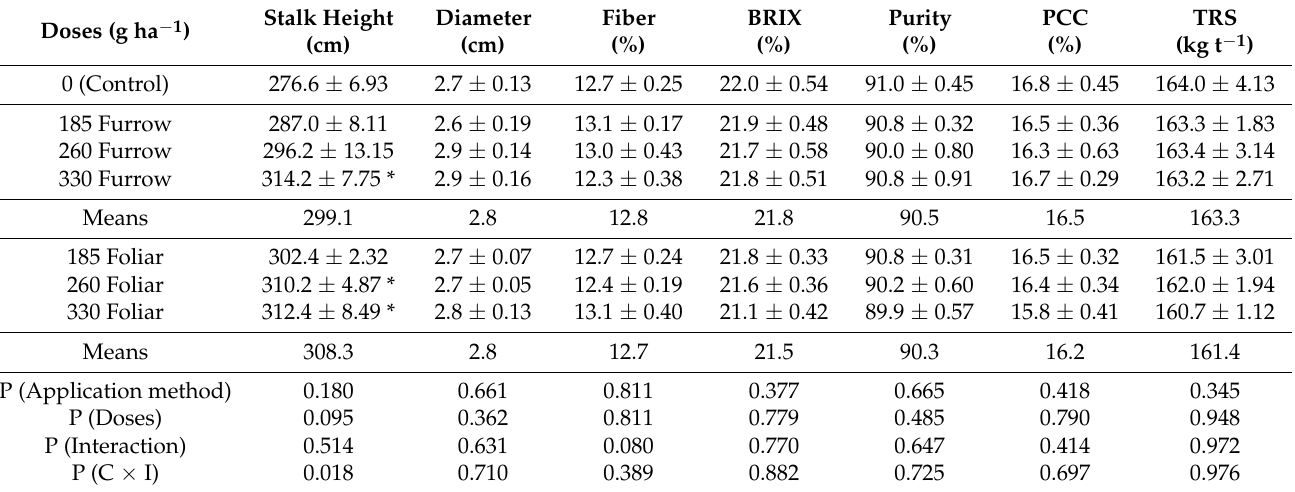
Table 5. Stalk height, stalk diameter, fiber% sugarcane, Brix% juice, purity, pol% cane (PCC), and total recoverable sugar (TRS) as a function of the dose and application method (df =